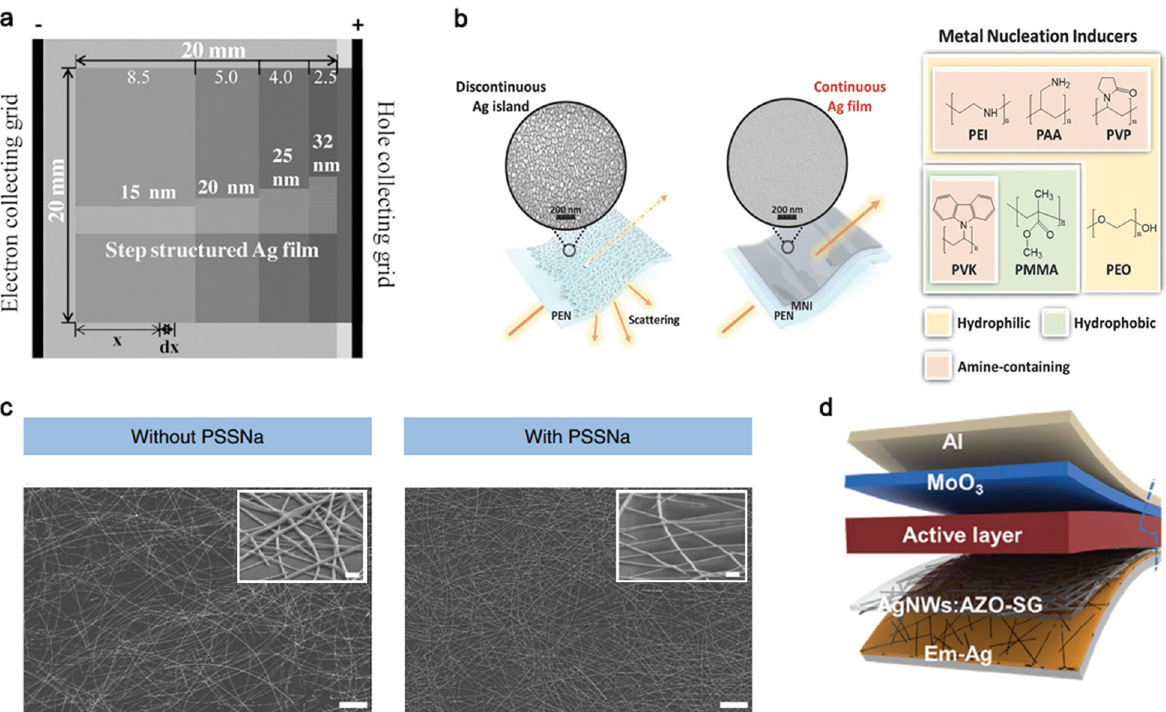
Fig. 2 The development of fl exible transparent electrodes for the large-area organic solar cells. a Top view of the structures of the thickness step-structured Ag layer 17 . b Schematic illustration of the ultrathin Ag FTEs and SEM images without and with a polymer nucleation- inducing seed layer on PEN substrates. Chemical structures of the polymer nucleation-inducing seed layers 51 . c Surface SEM images of the AgNWs fi lms prepared from the pristine AgNW suspension, AgNW suspension with PSSNa, scale bars, 4 μ m. The inset fi gures are the cross- section SEM images with scale bars of 200 nm 55,97 . d Schematic illustration of a fl exible OSC based on Em-Ag/AgNWs:AZO-SG FTE 57